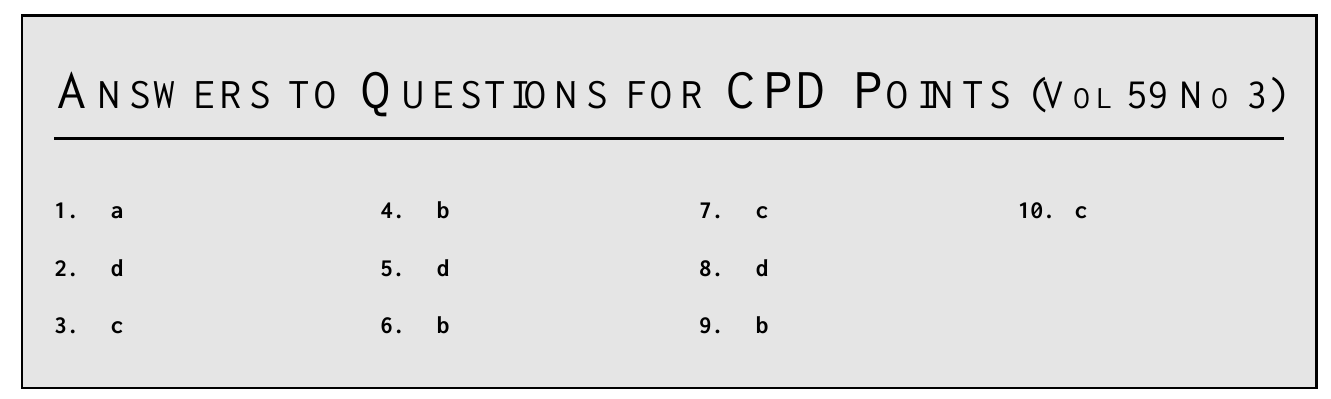
CPD P OINTS (V OL 59 N O